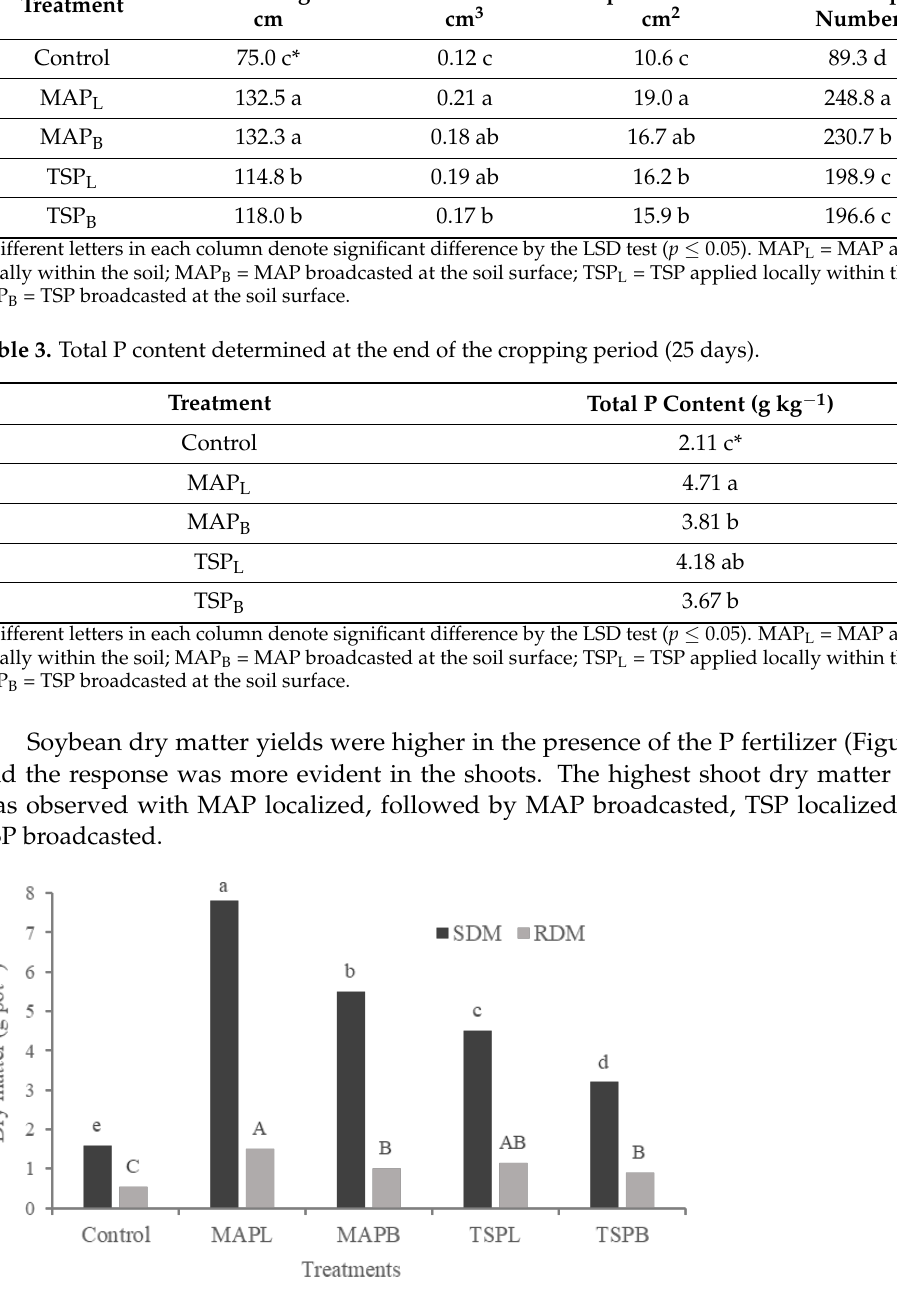
Figure 1. Soybean-shoot dry mass (SDM) and root dry mass (RDM) in response to different P sources and application forms. Different letters show significant differences (LSD, p ≤ 0.05), capitals show differences in shoot dry matter, and lowercase show differences in root dry matter. MAP L = MAP applied close to the seed furrow; MAP B = MAP broadcasted at the soil surface; TSP L = TSP applied close to the seed furrow; TSP B = TSP broadcasted at the soil